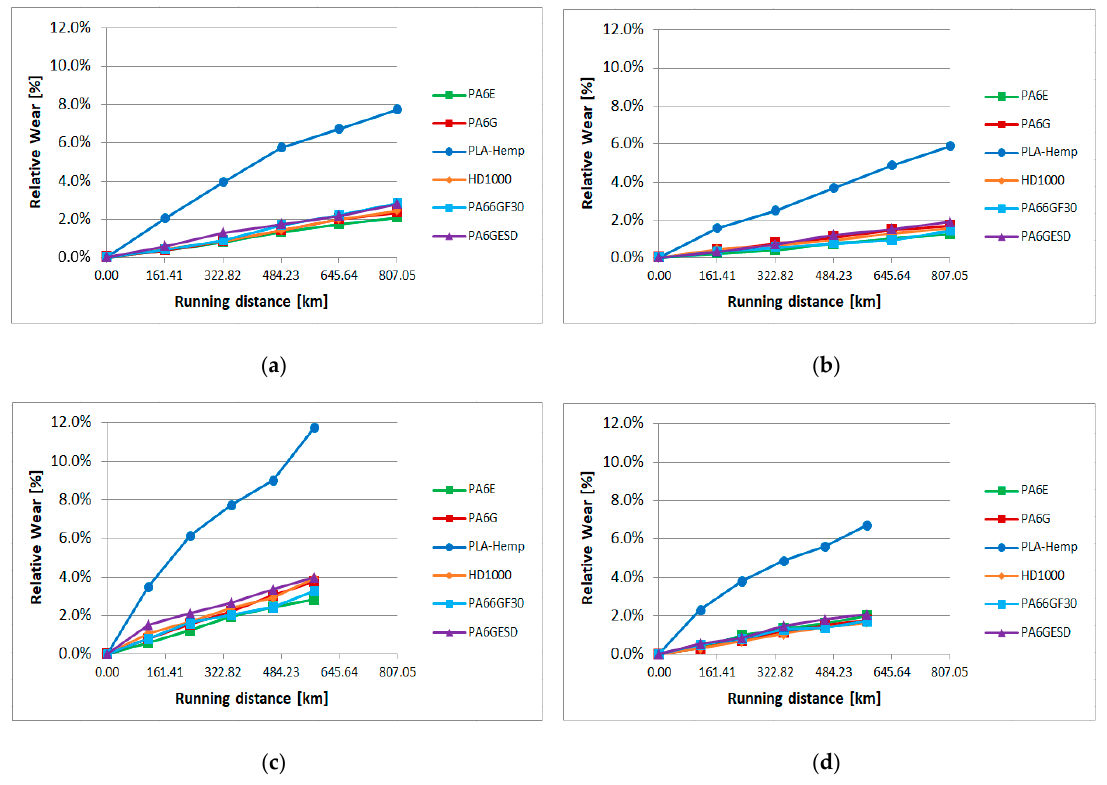
Figure 11. Relative wear of the tested materials in gravelly skeletal soil-based slurry ( a ) position 1, ( b ) position 2, ( c ) position 3, ( d ) position 4 (Figure 3).